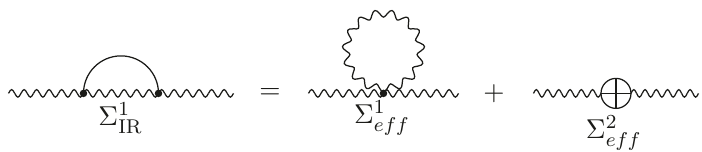
Figure 4 . Illustration of the one-loop match in the IR between fundamental theory (left side of equality) and the e(cid:11)ective theory with the four-scalar interaction (right side of equality). taking into account only the quartic interaction of the (cid:12)eld (cid:30) a at the one-loop level. At the (cid:12)rst stage, we shall disregard the correction (4.18) for the fundamental theory, since this contribution is independent of the momentum. The graphical representation of the one-loop matching is shown in (cid:12)gure